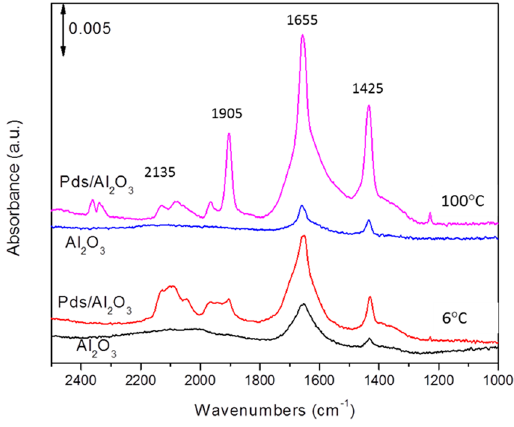
Figure 5. A comparison of in situ IR spectra during CO oxidation at 6 and 100 °C on θ -alumina and Pds/ θ -